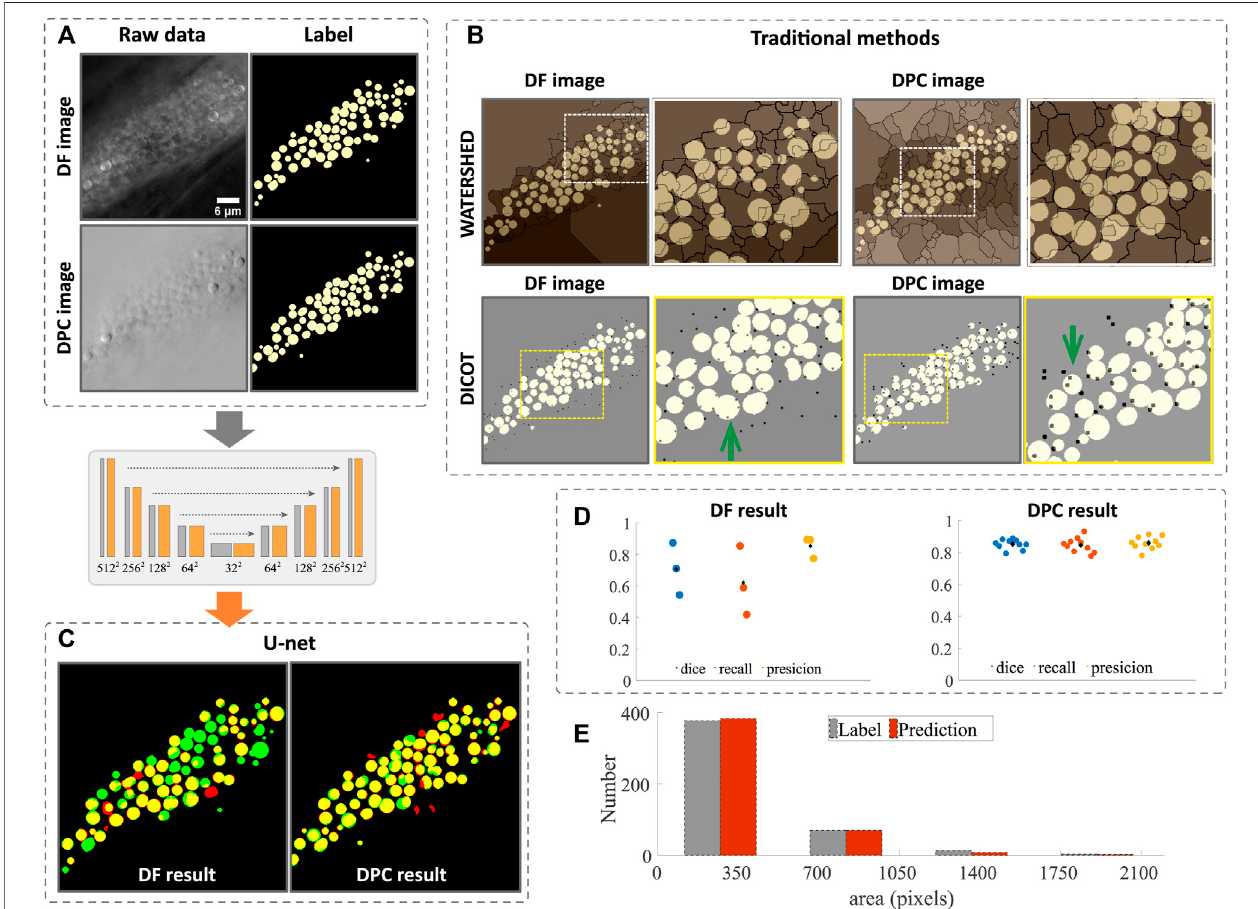
FIGURE 3 | Image segmentation and morphology analysis of lipid droplet in dense regions. (A) raw data of DF and DPC images and their ground truth annotated manually. (B) segmentationbytraditional methodsandthegroundtruthisshowninwhiteandtheedges(bywatershed)andbrightpeaks(byDIOCT)ofthelipiddroplets are shown inblack. One cansee that many edgesor the peaks are inthe wrong places.The segmentation results using CNN areshown in (C) and issigni fi cantly better. ThequantitativemeasureoftheDLsegmentationshownin (D) suggeststhattheaccuracyforDPCcaseisaround85%and70%forDFcase.Theareaandnumber of the lipid droplets are analyzed from DPC segmentation and is shown (E) along with the analysis based on manual segmentation. Scale bars in (B) represent 6 μ m .